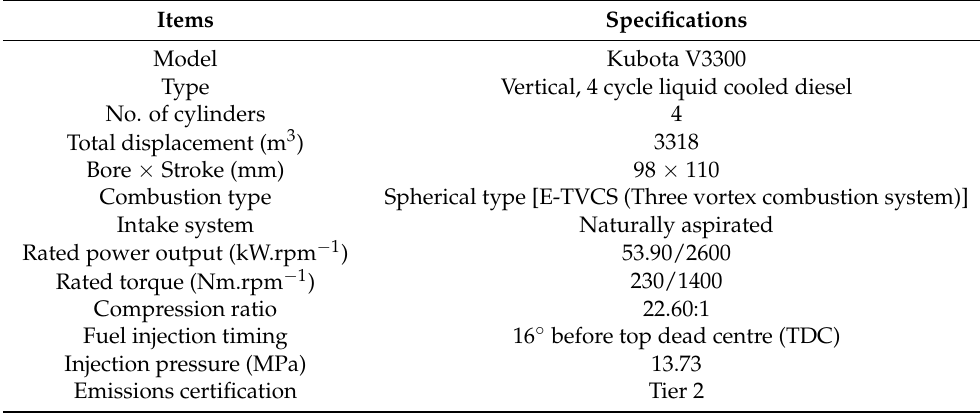
Table 2. Test engine